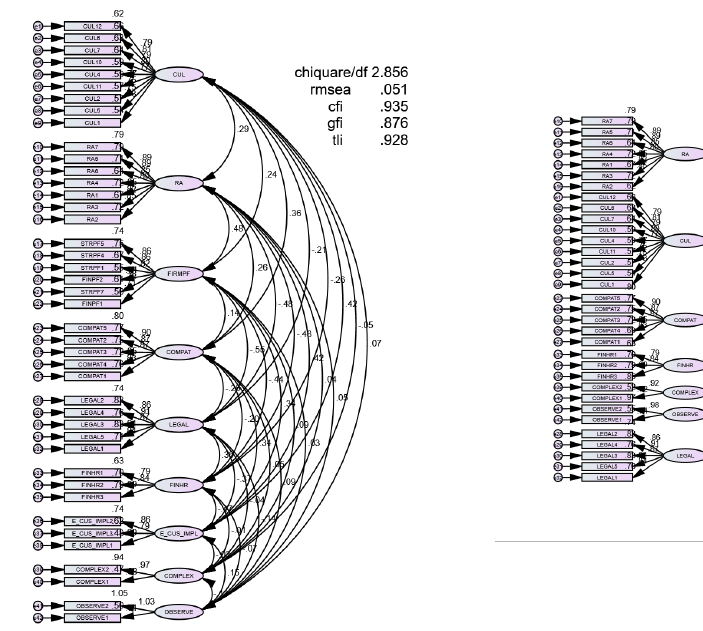
Fig. 2. The results of CFA Fig. 2. Standardised Path Estimates for Structure